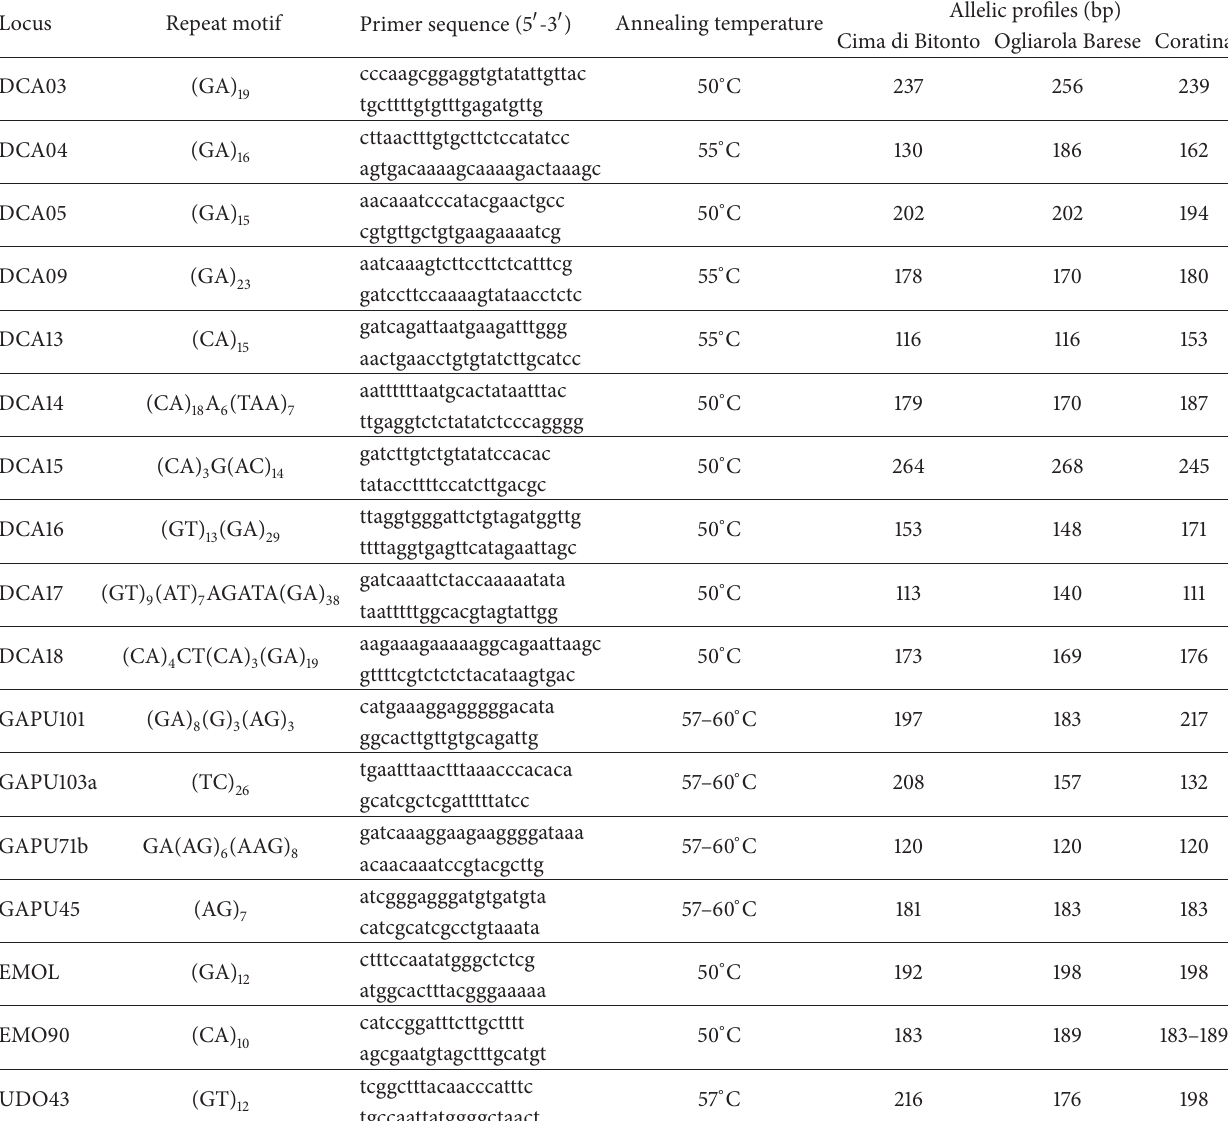
Table 1: Locus name, repeat motif, annealing temperature, primer sequences referred to SSR markers, and allelic profiles of the cultivars included in the PDO Terra di Bari olive oil.